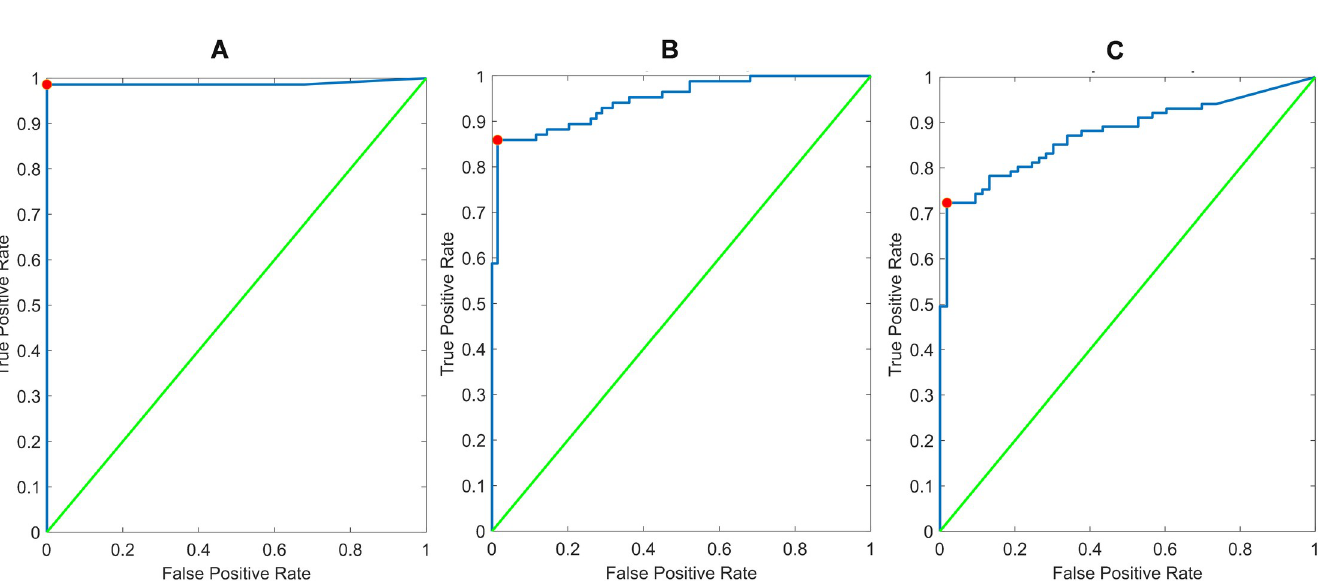
Fig 4. ROC curves for reader app performance versus (A) visual interpretation of GH labs assay, (B) AN swab PCR, and (C) NP swab PCR results. All represent use of the test line’s peak height above background metric extracted from the red channel of the high-resolution images acquired by the reader app. AUC values were 0.99, 0.95, and 0.88 for panels A, B, and C,